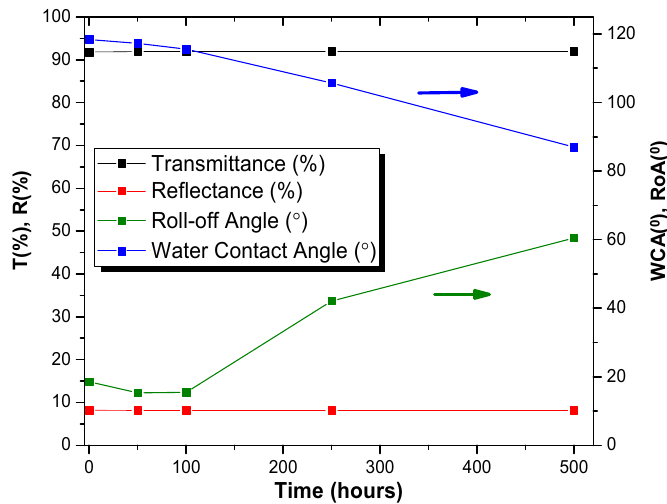
Figure 2. Transmittance (%T) and reflectance (%R) and corresponding water contact angle (WCA) and roll off Angle (RoA) measurements up to 500 h of UV exposure of a vacuum deposited hydrophobic coating (A). Transmittance and reflectance values were collected at 550 nm.